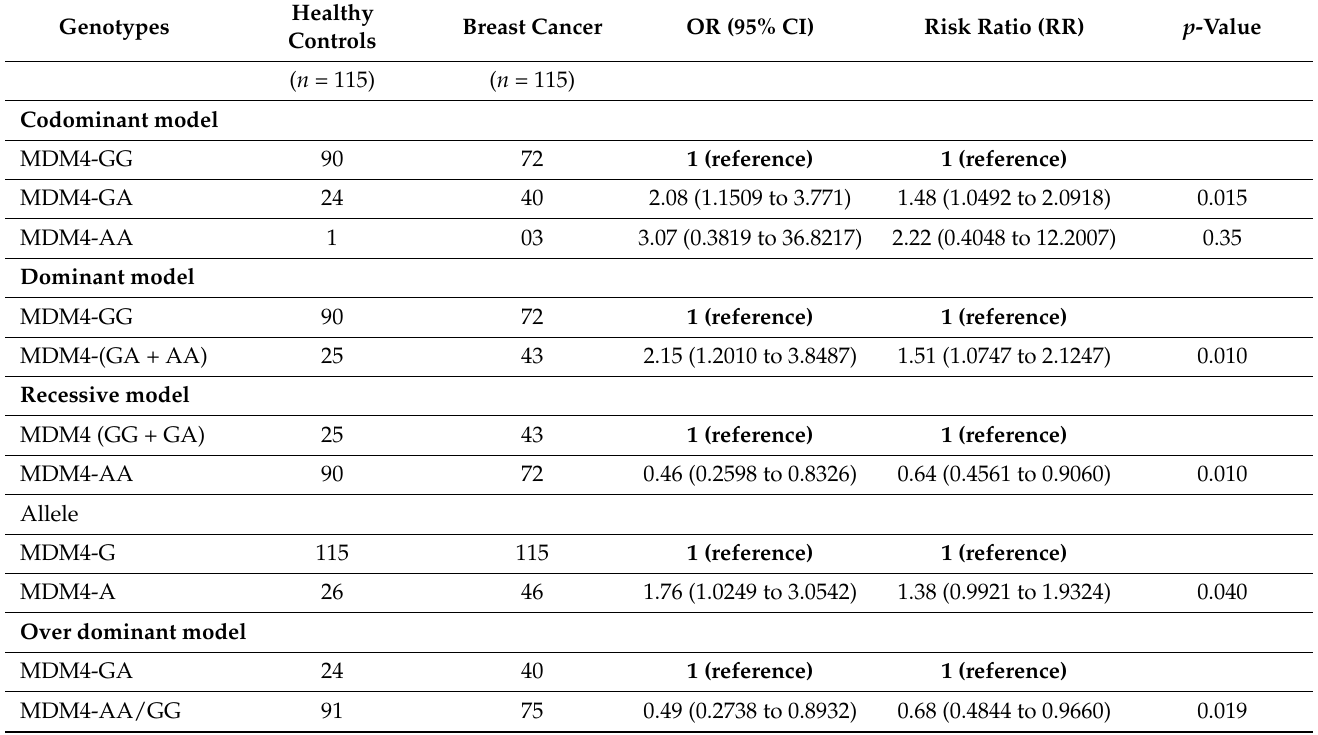
Table 7. Association of MDM4 rs11801299 G > A genotypes with breast cancer risk.